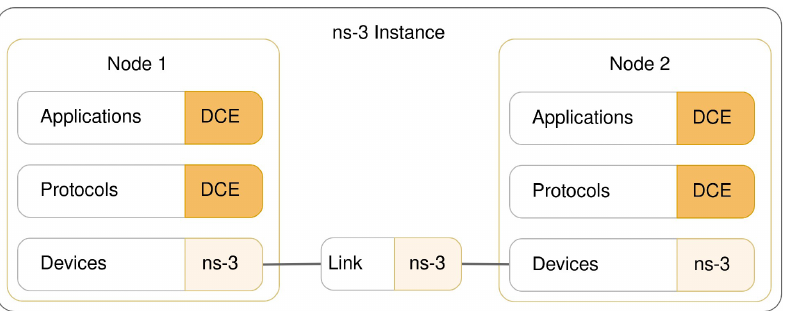
Figure 2. DCE is used for running Linux applications without code changes. On top of that, it enables the use of the Linux network protocol stack in ns-3 simulations. Net devices (and channel) are simulated only with ns-3, while applications and network protocols can use